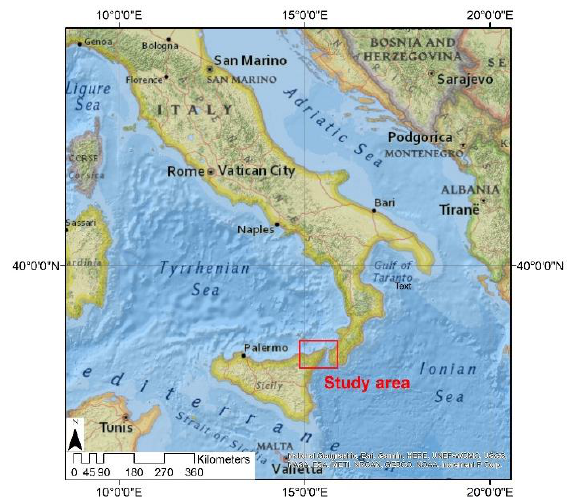
Figure 1. Study area in WGS 1984 Web Mercator Auxiliary Sphere projection (EPSG:3857).